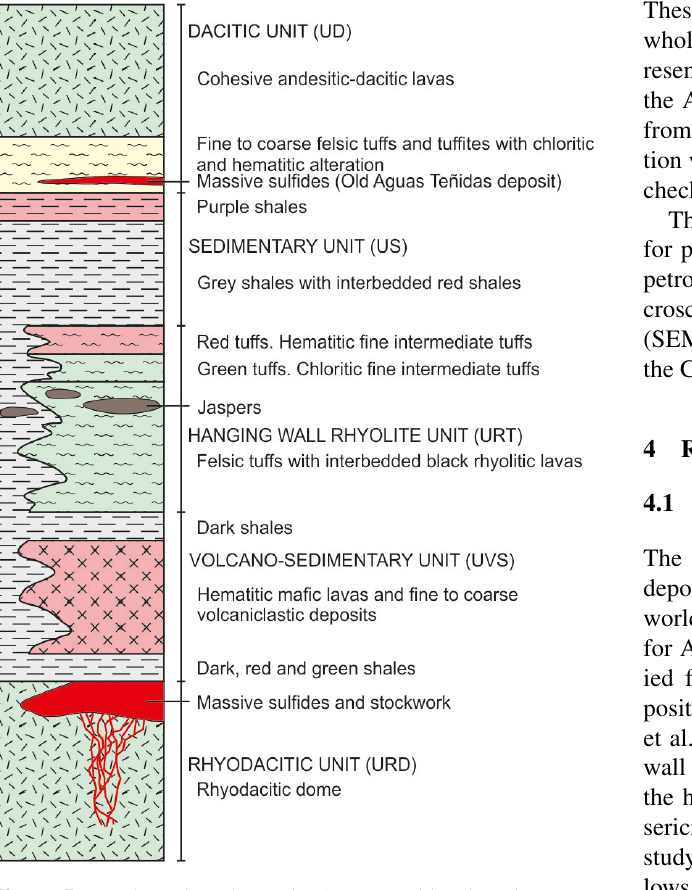
Figure 5. Local stratigraphy at the Aguas Teñidas deposit; not to scale. Nomenclature follows original description by MATSA. Mod- ified from